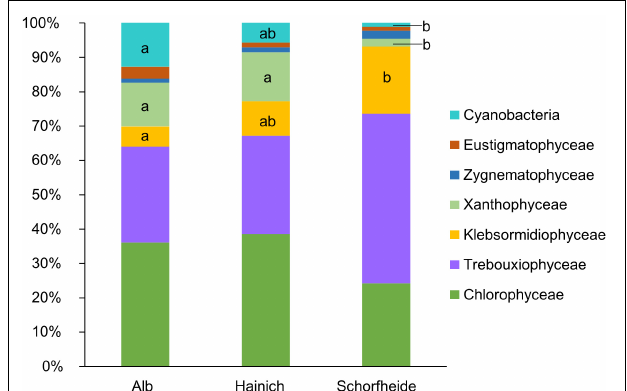
FIGURE 2 | Taxonomic composition of algae community on class level in biocrusts from temperate forests at three sampling sites; significant differences between the three sites were estimated by ANOVA followed by post hoc Tukey test and are indicated with letters; n = 9 for each sampling site.